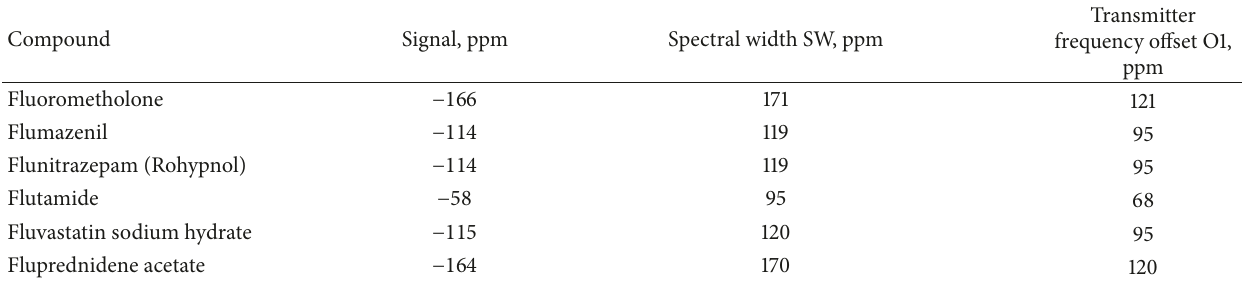
soluble compounds. 6